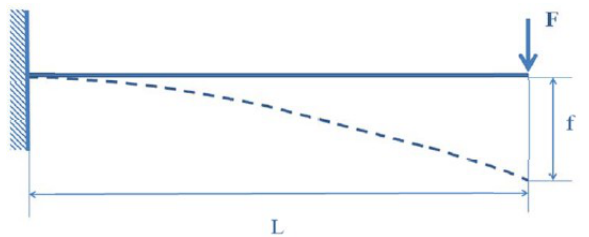
Figure 2. The used mechanical model.